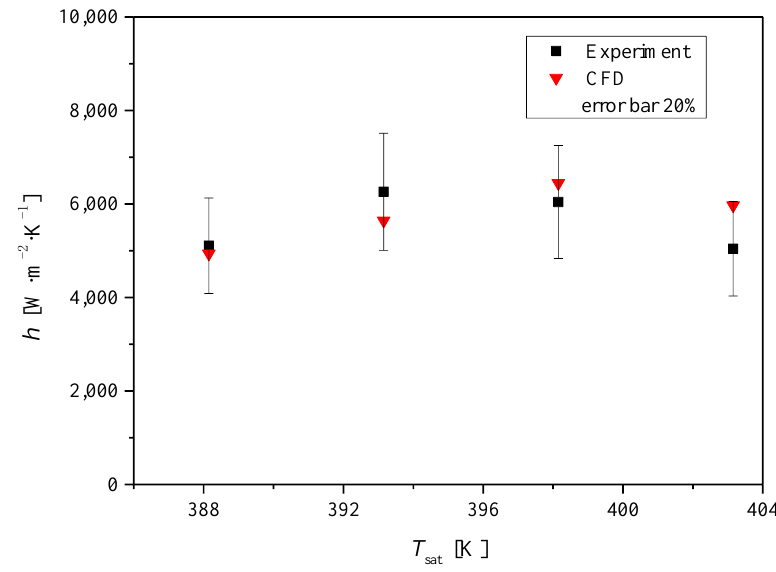
Figure 6. Comparison between the calculated result and experimental data.